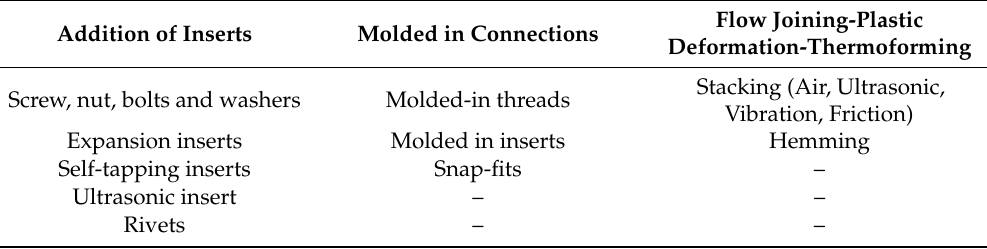
Table 1. Type of mechanical fastening.